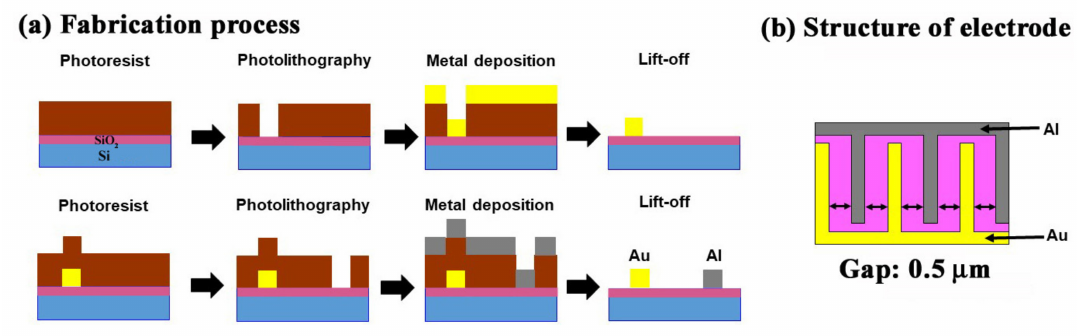
Figure 1. ( a ) Schematic flow of the fabrication process of a sensor with the arrangement of Al and Au electrodes on the SiO 2 substrate, and ( b ) the structure and placements of